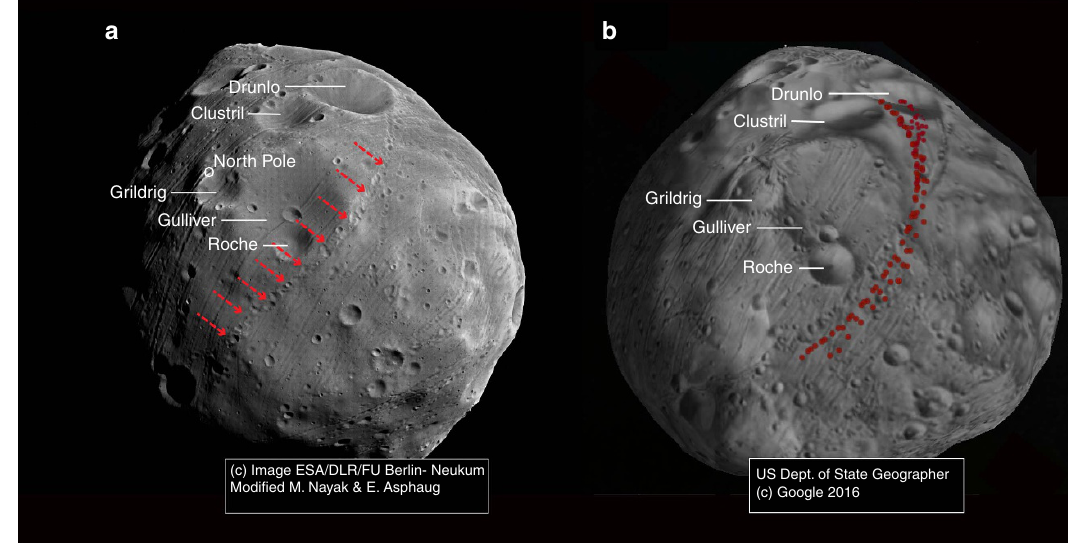
Figure 6 | Tracing an observed catena back to its source crater. ( a ) Spacecraft image of Phobos (photo credit: ESA/Mars Express) showing the observed catena of interest (red arrows); ( b ) reimpact map for a primary impact at Grildrig, azimuth b A [0: p = 36 : 2 p ) rendered in three dimensions. Relative sizes and orientations between a and b are similar and may be correlated from Drunlo, Clustril, Grildrig, Gulliver and Roche craters, respectively. From the correlation, the highlighted catena likely originates from sesquinary ejecta from